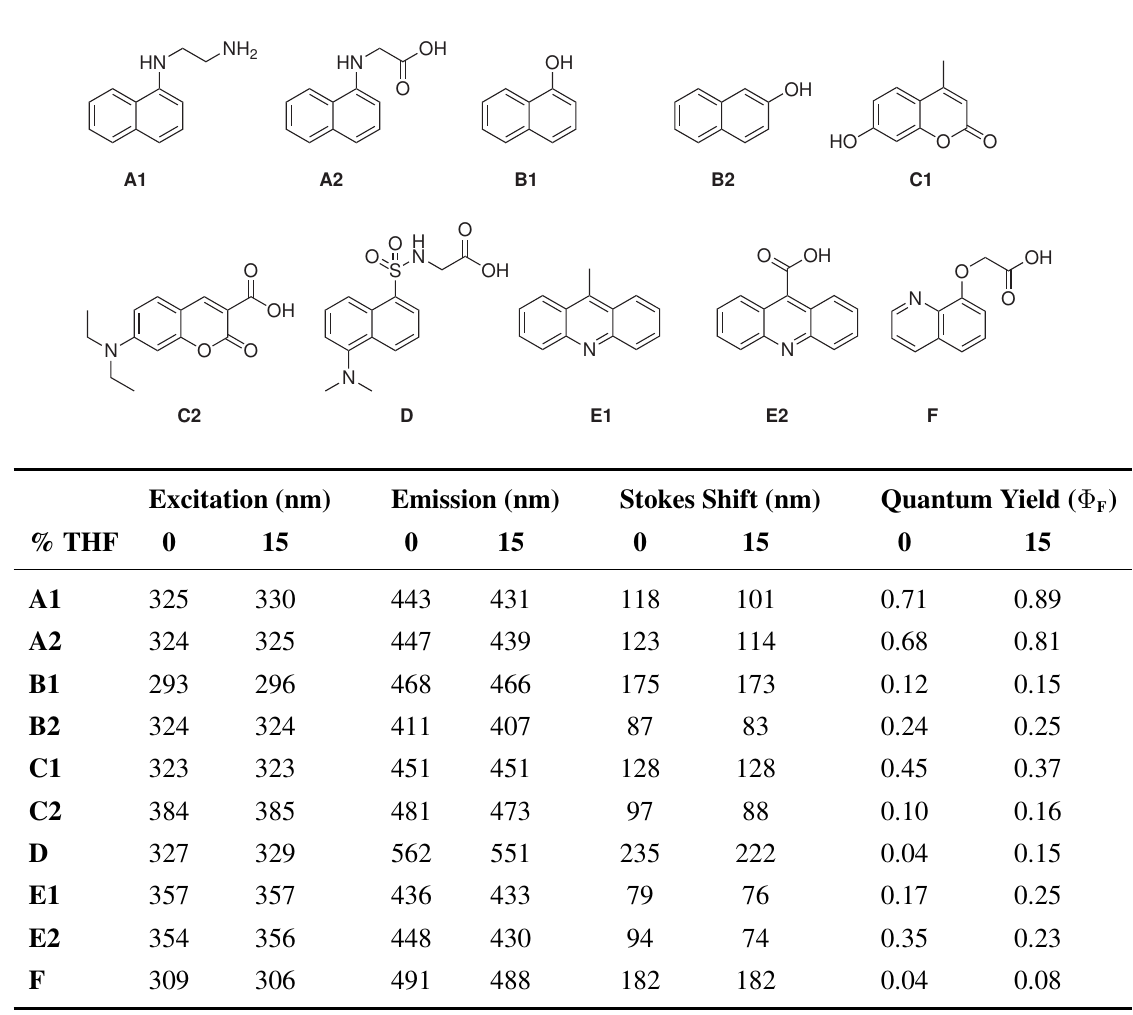
Table 4. Small library of fluorophores as the FRET acceptors in conjunction with tryptophan as the FRET donor and their fluorescence properties at different levels of THF in neutral phosphate buffer